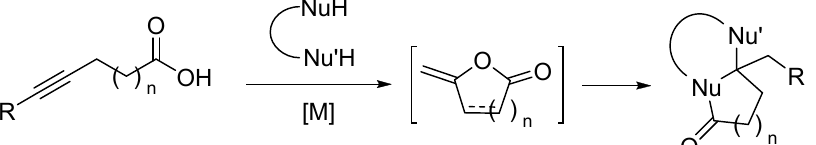
Scheme 1. An overall picture of metal-catalyzed cascade reaction of acetylenic acids and dinucleo- philes.